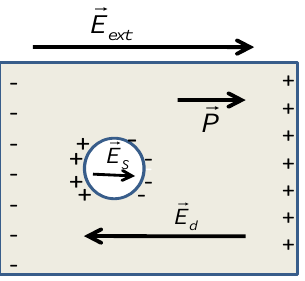
Figure 1. Auxiliary sphere around a molecule for determining the local electric field.